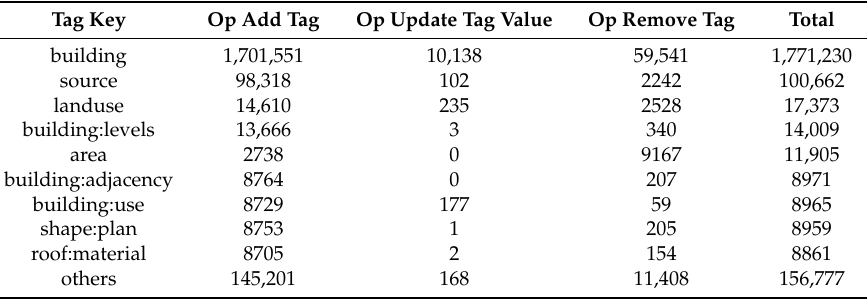
Table 9. Tag operations for feature type building after the earthquake in Nepal.